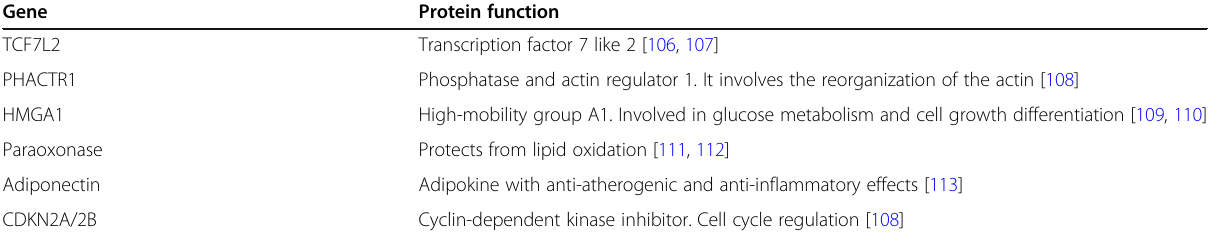
Table 5 Genes whose variants increase the risk of DM and CVD Gene Protein function TCF7L2